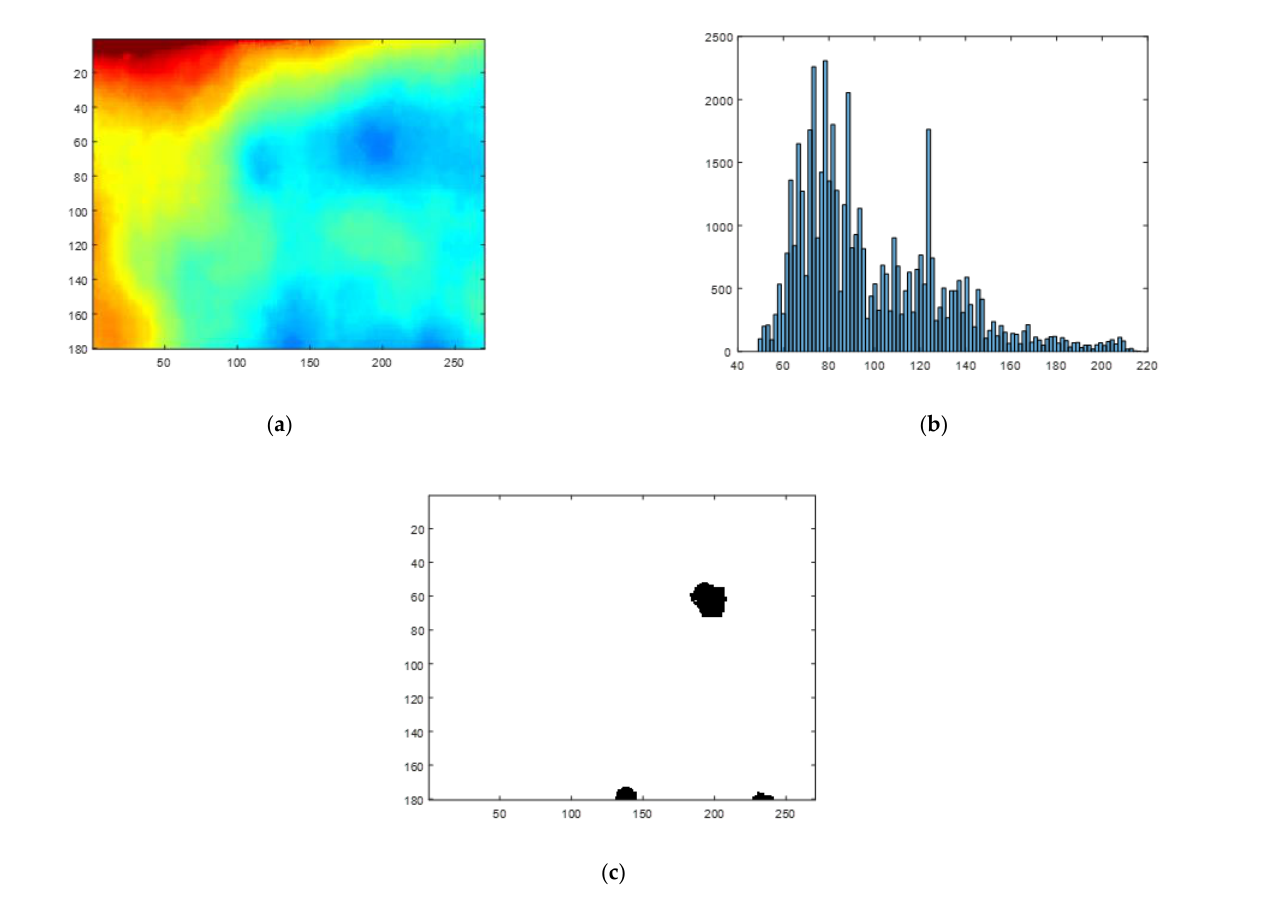
Figure 13. ( a ) Sample IR image; ( b ) image histogram; and ( c ) identified leakage locations.